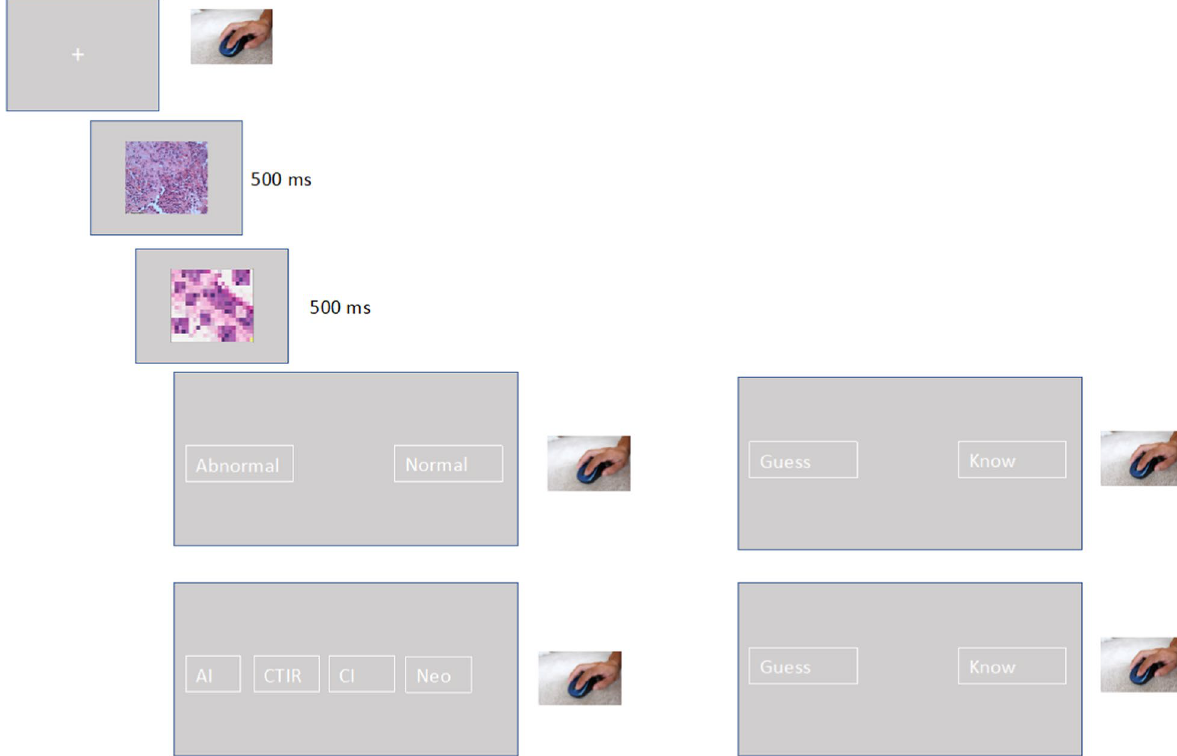
Fig. 3 Schematic of gist experiment. Participants saw a brief (500 ms) flash of a histology image which was then masked. They made a normal/ abnormal judgment and then reported how they made this judgment. If they had selected an abnormal judgment, after reporting how they made that judgment, they were then presented with the 4 histopathology categories and selected one of them. They then reported how they made this category